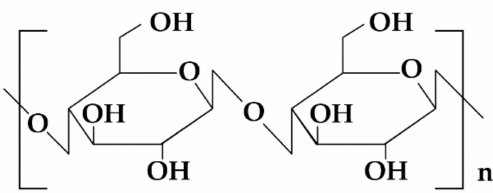
Figure 1. Schematic illustration of cellulose structure. Table 1. Properties of cellulose derivatives depending on their functional groups [5,9,15,16,18–20]. Cellulose